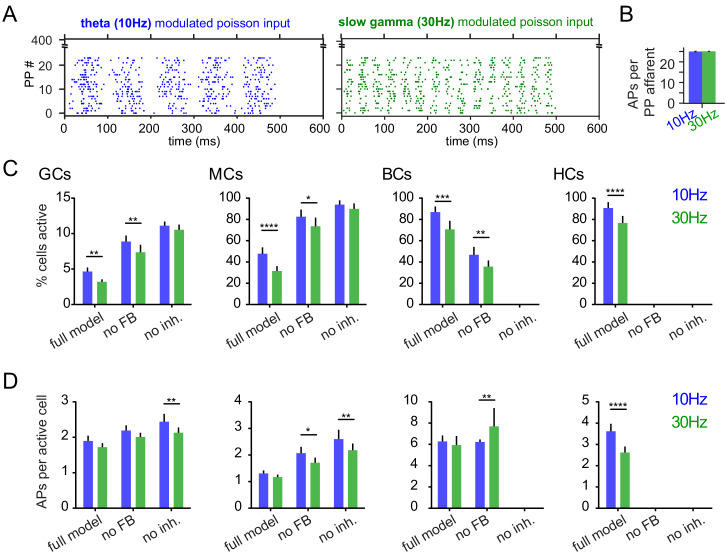
Activity levels and pattern separation.(GCs: granule cells; MCs: mossy cells; BCs: basket cells; HCs: HIPP cells; n = 7 model runs). (A) Exemplary raster plots of 10 Hz and 30 Hz modulated inputs. (B) Mean number of action potentials per active perforant path afferent. (C) Percentages of active cells within the model. (D) Mean number of action potentials per active cell within the model. Activity rates (A, B) were tested with two-way ANOVAs followed by Sidak’s posttests for differences between frequencies. Asterisks indicate significance in posttests given significant overall effects (*p<0.05, **p<0.01, ***p<0.001, ****p<0.0001).